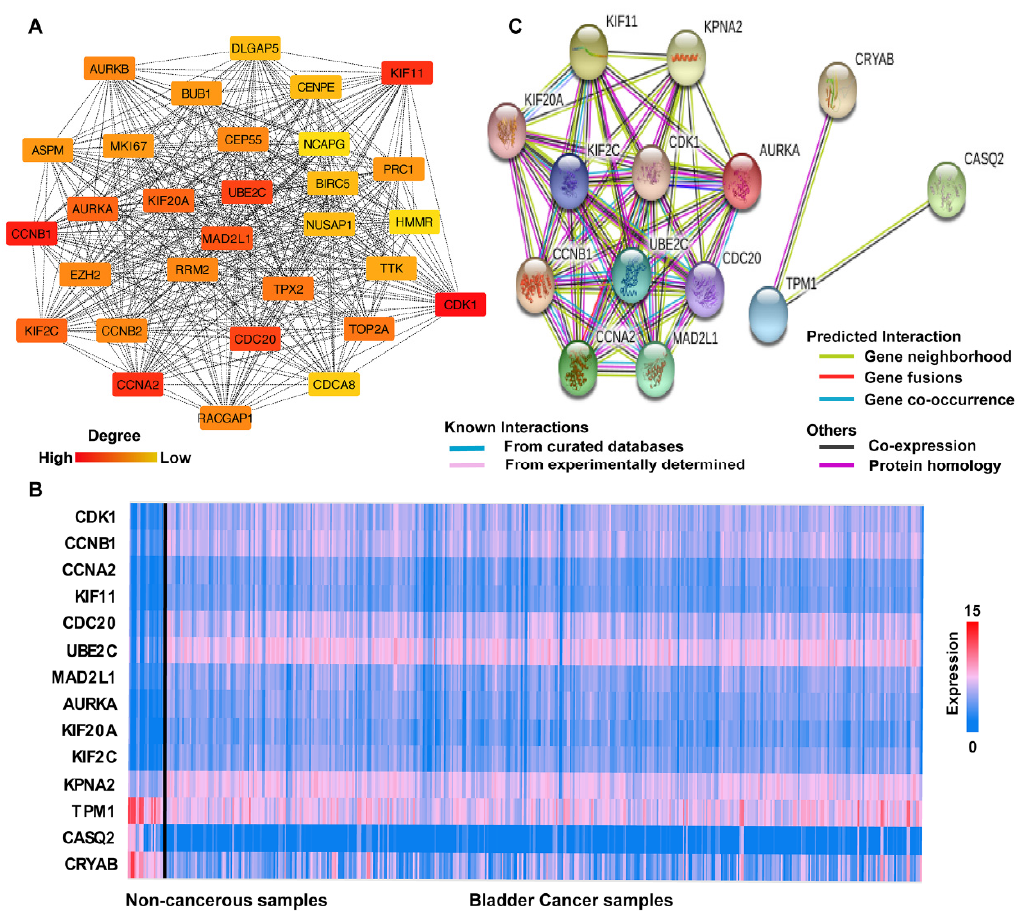
Figure 4. Interaction network analysis and expression of the hub genes. ( A ) The interactions and protein-protein networks of the top 30 hub genes. ( B ) Hierarchical clustering of 14 hub genes analyzed in the present research. The samples on the left of the black bar are noncancerous bladder tissues from the TCGA-BLCA dataset ( n = 19) and the samples on the right of the black bar are BCa samples ( n = 406): high expression (red), low expression (blue). ( C ) Protein-protein network and interaction among the 14 hub genes from STRING-db.org, accessed on 11 November 2019. Nodes with di ff erent colors represent di ff erent query proteins. A di ff erent color on the edge means a di ff erent interaction (see legend in